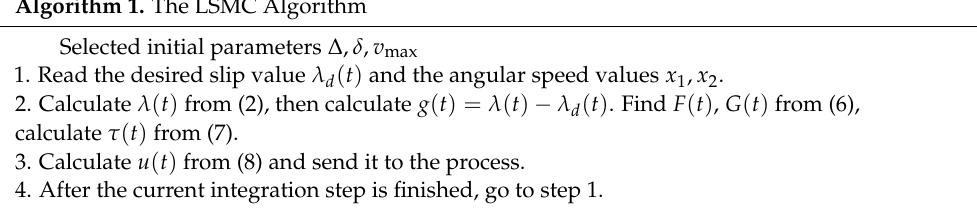
Algorithm 1. The LSMC